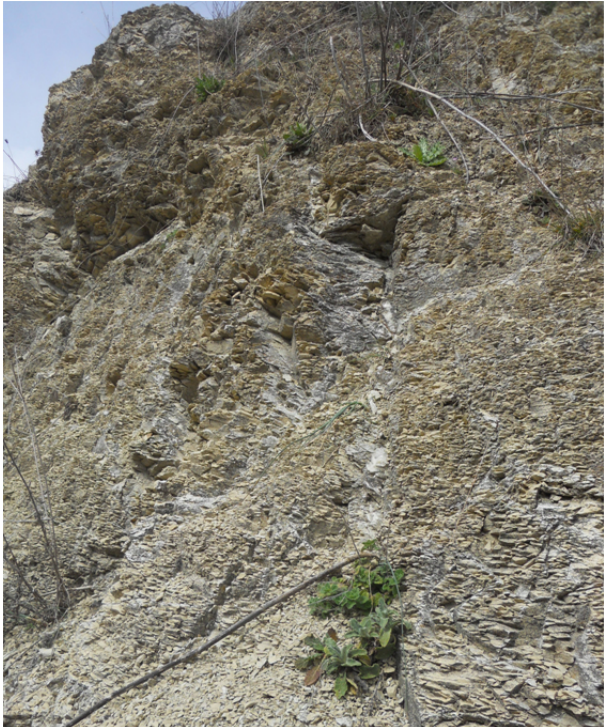
Figure 6. Exposure of the Gorgoglione Flysch arenaceous-marly sequence. Grey and whitish marls, silty marls and marly clays, strongly fragmented in slivers and scraps.